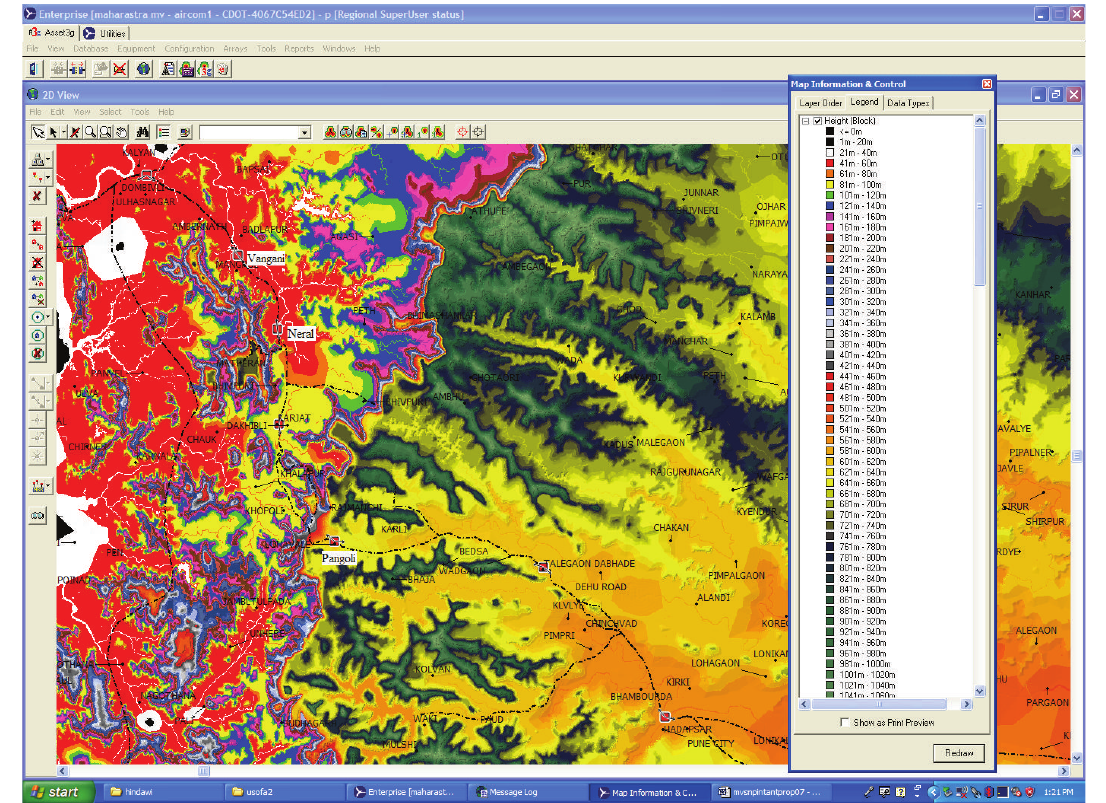
Figure 4: Terrain variation of west Indian base stations.